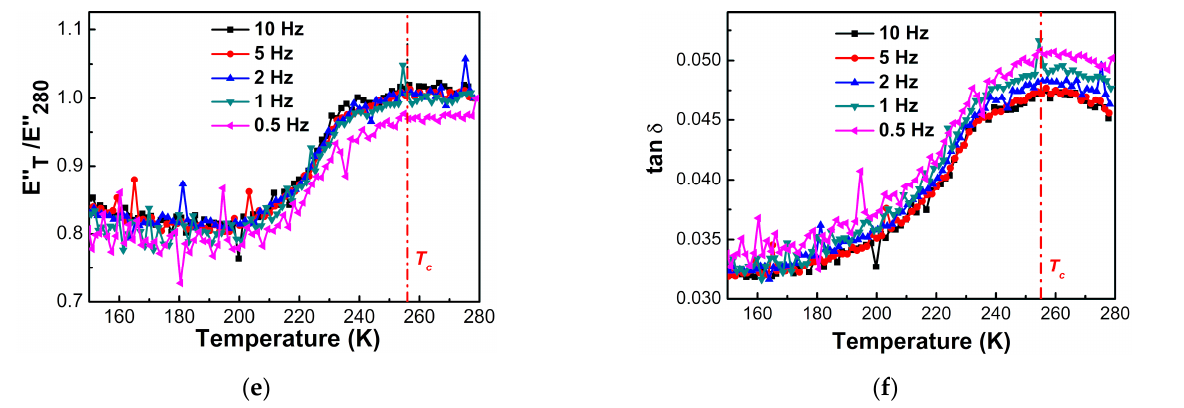
Figure 6. Temperature dependences of ( a ) storage modulus E’, ( b ) loss modulus E”, ( c ) loss factor tan δ of [NH 4 ][Mg(HCOO) 3 ] single crystals, ( d ) normalized storage modulus E’ T /E’ 280 , ( e ) normalized loss modulus E” T /E” 298 and ( f ) loss factor tan δ of [NH 4 ][Mg(HCOO) 3 ] pellet determined by DMA during heating at the rate of 2 K/min. The vertical dash-dotted line indicates the ferroelectric transition temperature of 256 K.